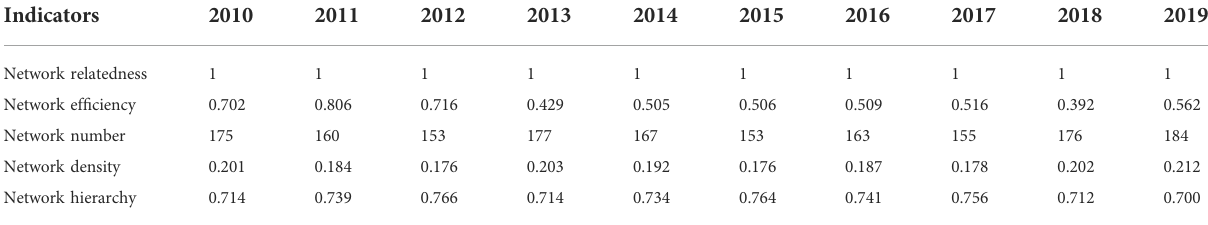
TABLE 5 Overall characteristic indicators of the spatially linked network of carbon emission ef fi ciency in China ’ s logistics industry, 2010 – 2019.